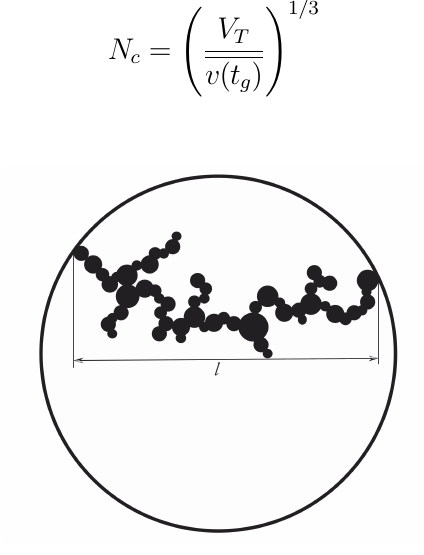
Figure 7. If the particles for during aggregation the cluster consist of particles with different size. Still gelation is assumed to occur, if a spanning cluster of particles now having all the different sizes expands from one side of the suspended drop to the